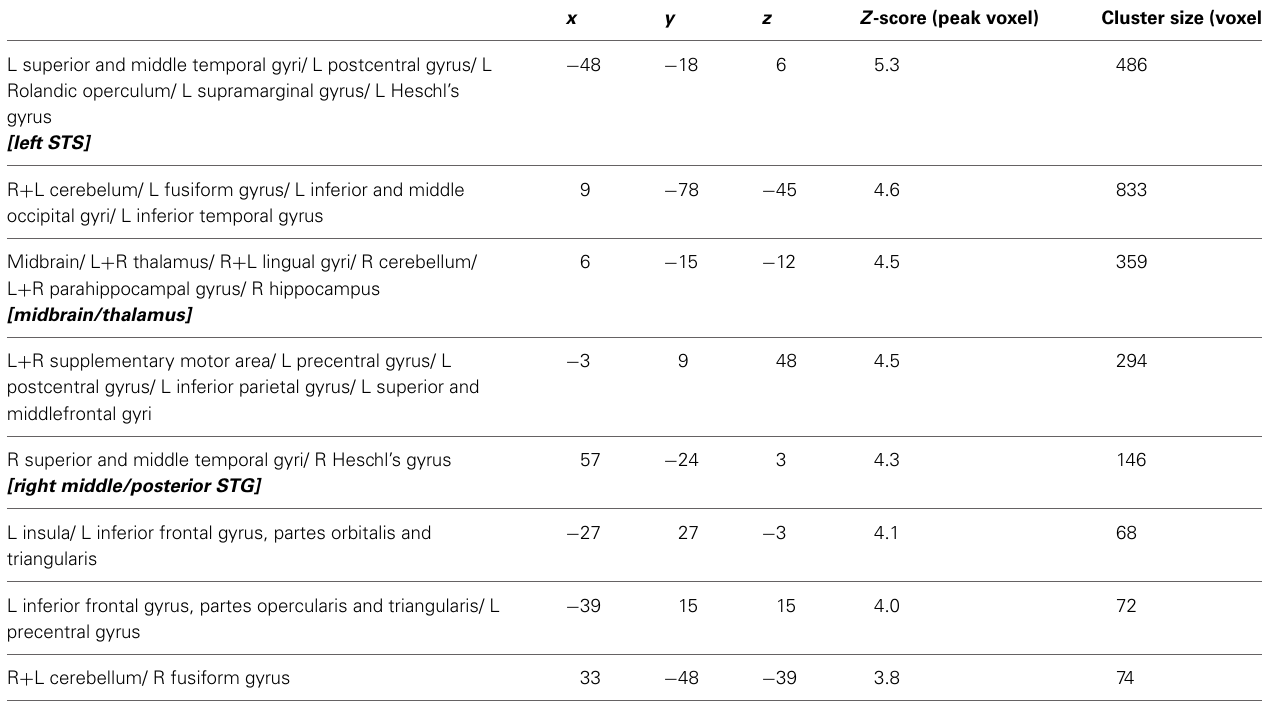
Table 1 | Brain areas with training (NECT) specific changes in their responses to non-verbal cues from voice and face as determined by the whole-brain interaction analysis between time point (T0, T1) and training type (NECT, SUDOKU). x y